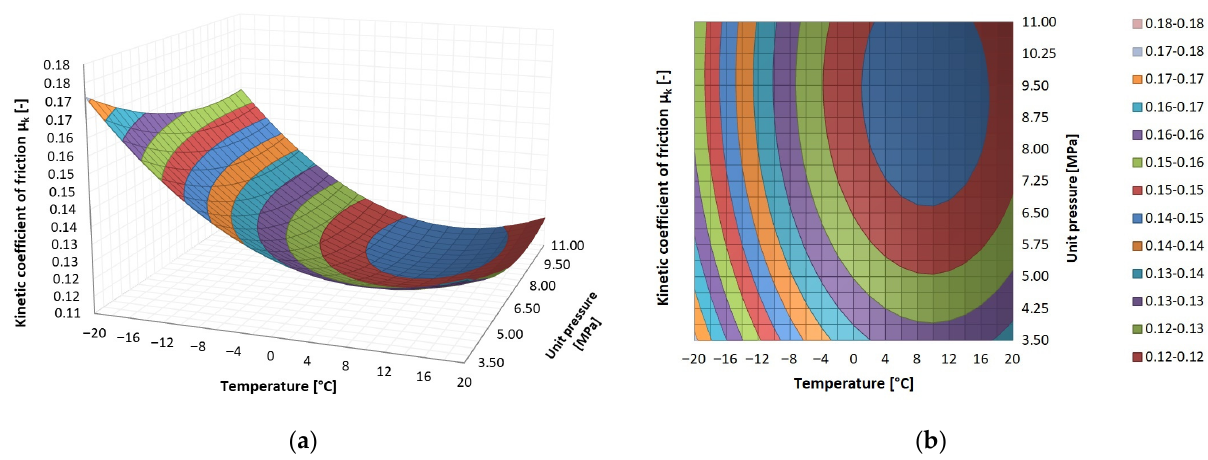
Figure 6. Dependence of kinetic friction coefficient μ k on temperature and contact pressure for PA6: ( a ) surface graph, ( b ) area graph.